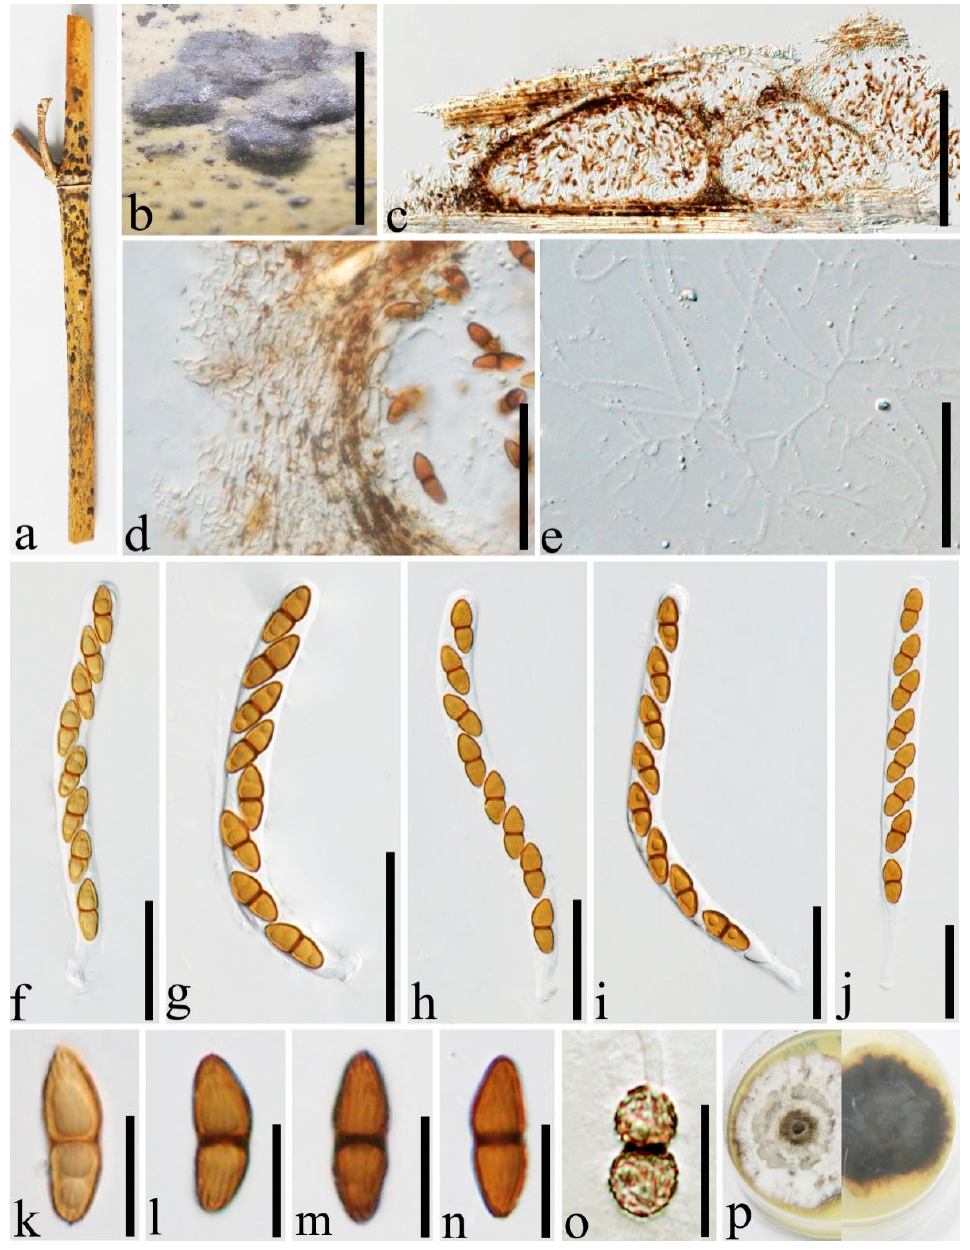
Figure 6. Roussoella nitidula (GMB1270, new country record). ( a ) Bamboo specimen; ( b ) black ascostromata on host surface; ( c ) vertical sections of ascomata; ( d ) cells of locule wall. ( e ) pseudoparaphyses; ( f – j ) asci; ( k – n ) ascospores; ( o ) Germinating ascospore; ( p ) Cultures on PDA from above and below. Scale bars: ( b ) = 1 mm, ( c ) = 500 μ m, ( d ) = 50 μ m, ( e – j ) = 30 μ m, ( k – n ) = 10 μ m, ( o ) = 15 μ m. Roussoella papillate Dai and Wijayaw. sp. nov. Figure 7.